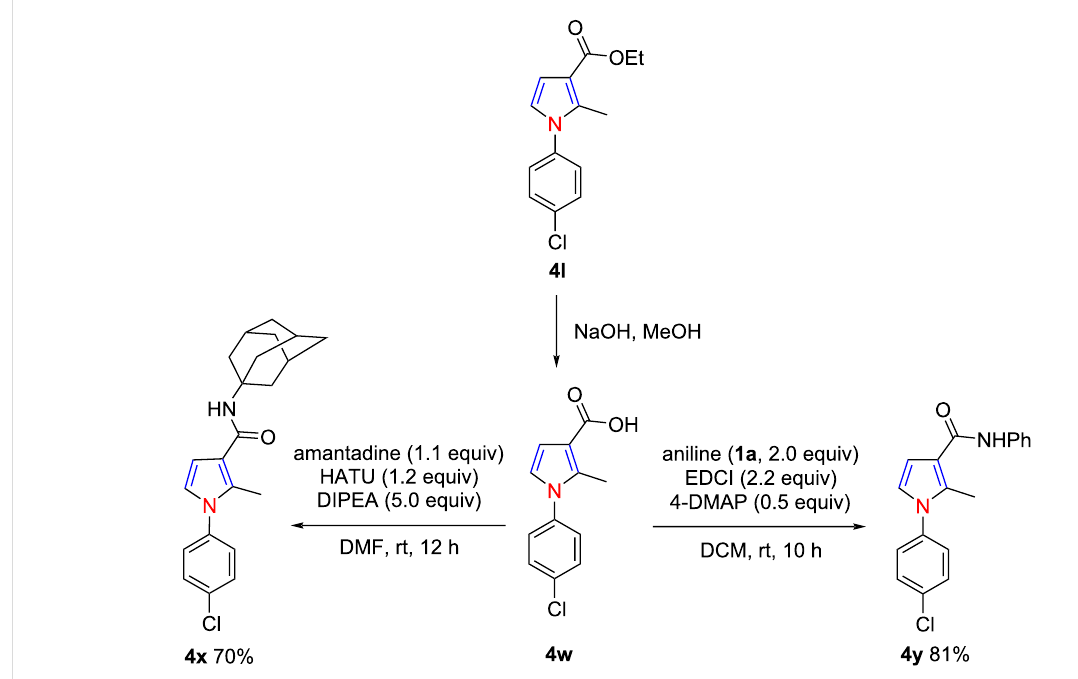
Scheme 4: Direct synthesis of pyrrole-3-carboxamide derivatives.